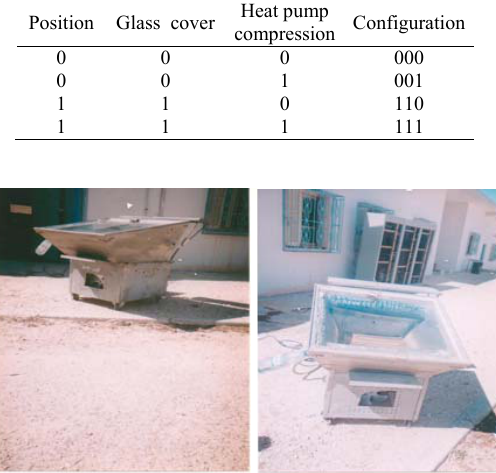
Fig. 2. Simple solar distiller hybrid with Heat Pump still: